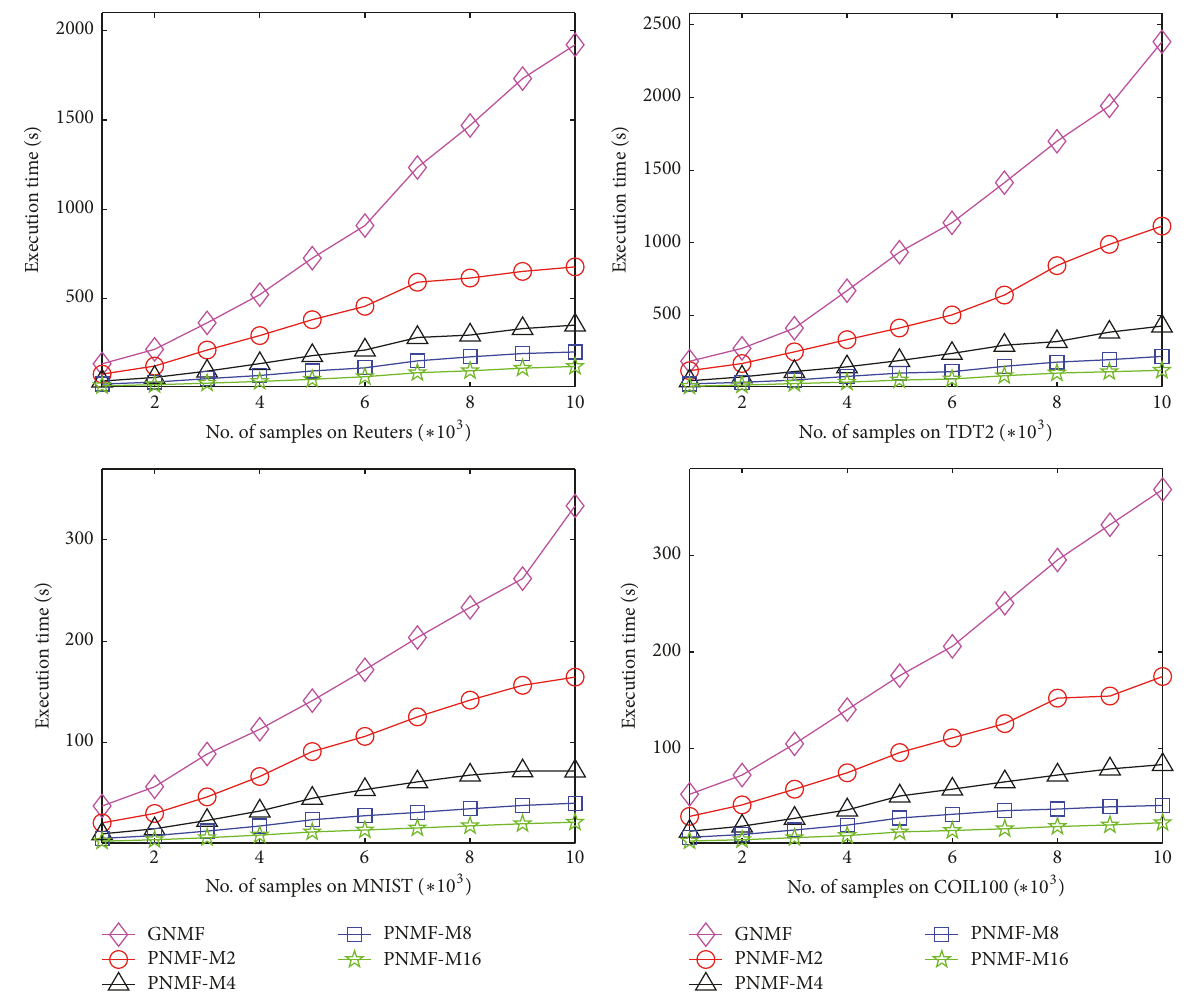
Figure 10: Execution time on four benchmark